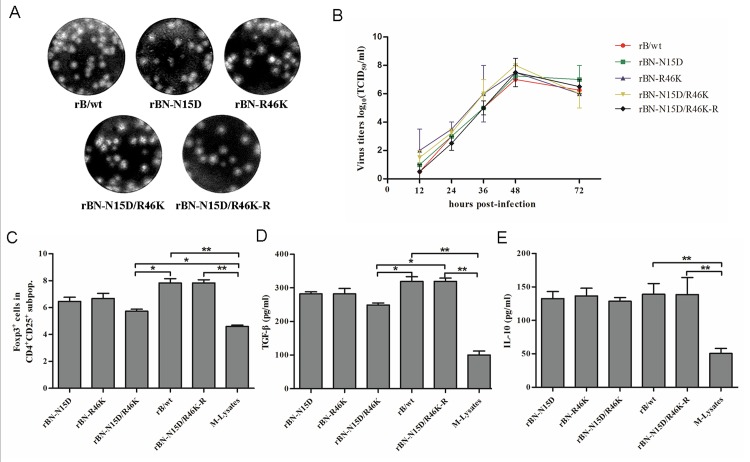
Effects of the mutant recombinant PRRSV strains on Tregs induction.(A) Plaque morphology assay of the recombinant mutant strains. (B) Growth kinetics of the recombinant mutant strains. (C) Percentage of Foxp3+ cells in the gated CD4+CD25+ subpopulations of the recombinant viruses. (D) Concentrations of TGF-β in the supernatants of 3-day co-cultures. (E) Concentrations of IL-10 in the supernatants of 3-day co-cultures. All data are represented as the means ± standard deviation of three independent experiments, and data analysis was done using one-way ANOVA and significant differences are shown (*P<0.05 and **P<0.01).